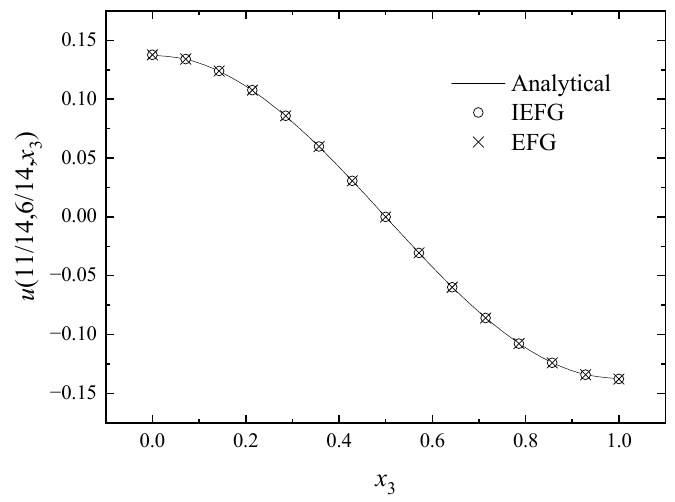
Figure 18. The comparison of numerical and exact solutions along x 3 -axis.